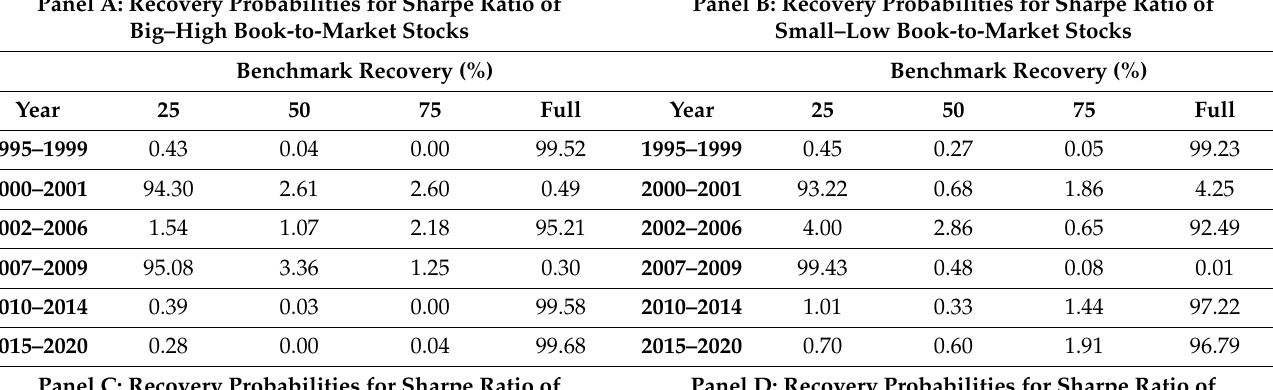
Panel C: Recovery Probabilities for Sharpe Ratio of Panel D: Recovery Probabilities for Sharpe Ratio of Big–High Investment Stocks Small–Low Investment Stocks Benchmark Recovery (%) Benchmark Recovery (%)